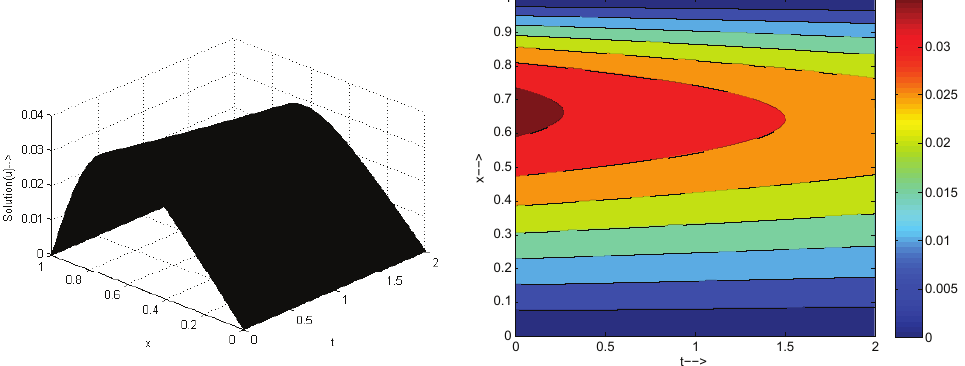
Fig. 12: Physical behavior of numerical solutions of Example 3 at different times in 3D and contour for Δx = 0.0125 , ν = 0.01 at different times with Δt = 0.001 .